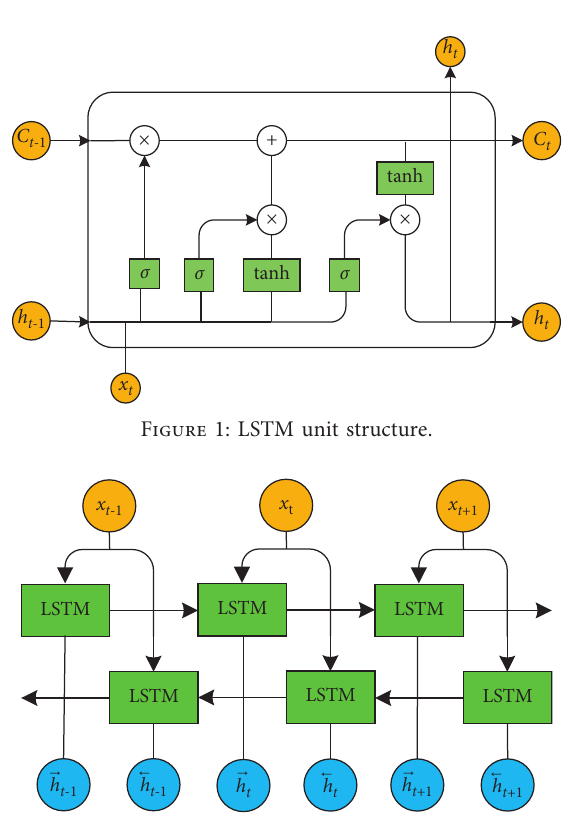
Figure 2: BLSTM unit structure.